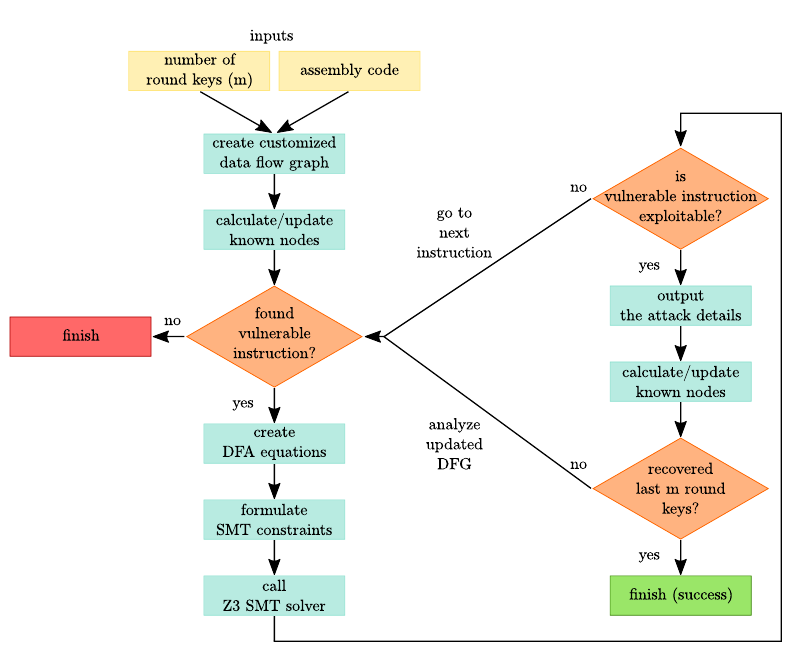
Figure 1: Overview of